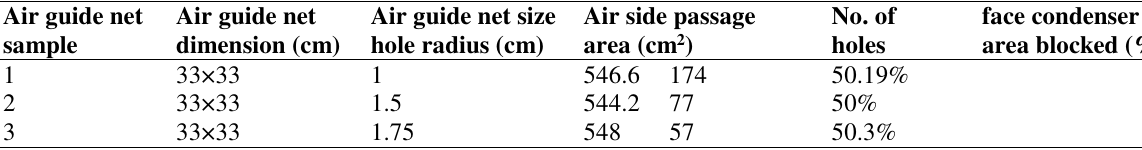
Geometric dimensions of the air guide net.